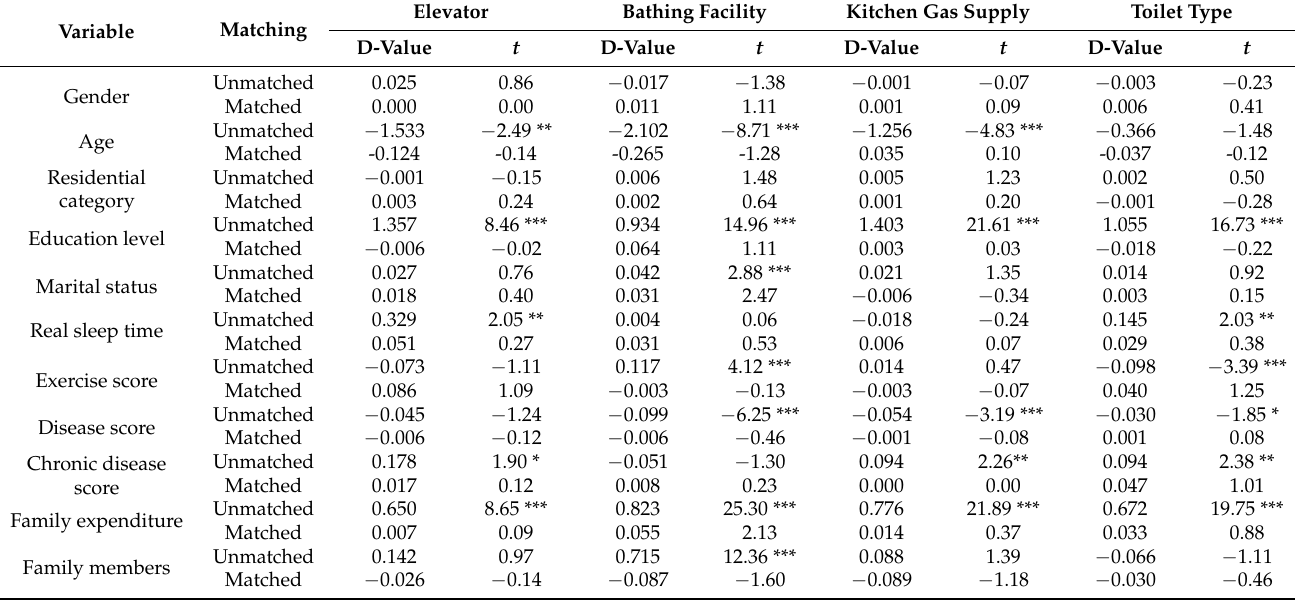
Table 3. Balance test.